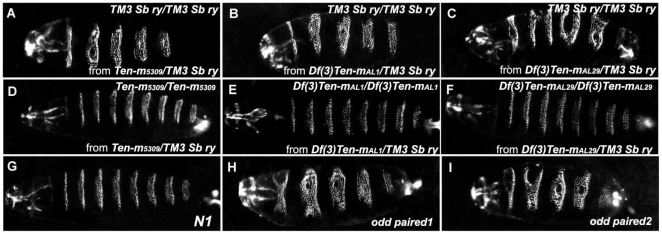
Tenascin-m is not a pair-rule gene.(A–I) Cuticles of dechorionated and devitellinized embryos were prepared to visualize exoskeletons and segmentation phenotypes. The cuticle phenotypes in the original Ten-m mutant stock and odd paired alleles are shown. The new Ten-m N1 allele and rebalanced reference alleles fail to reproduce a pair-rule phenotype. Embryos shown are derived from the original: 5309 (A and D) ; Df(3L)Ten-mAL1 (B and E); and Df(3L)Ten-mAL29 (C and F) stocks. (G) N1, (H) odd paired1, and (I) odd paired2. Embryos are oriented: anterior-left.